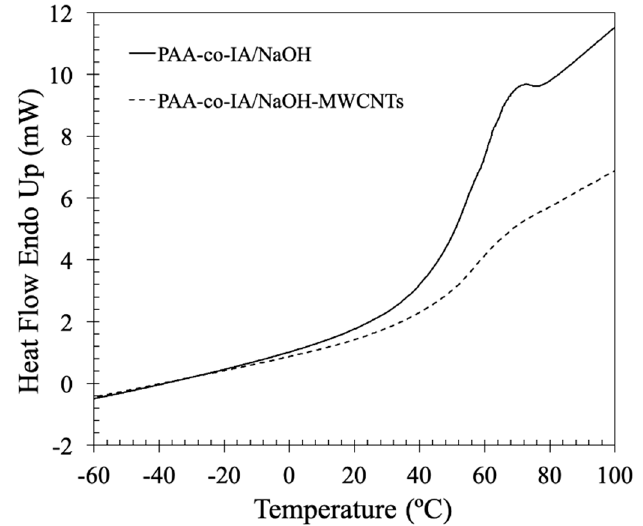
Figure 6. DSC thermograms of the PAA-co-IA and PAA-co-IA/NaOH hydrogels.